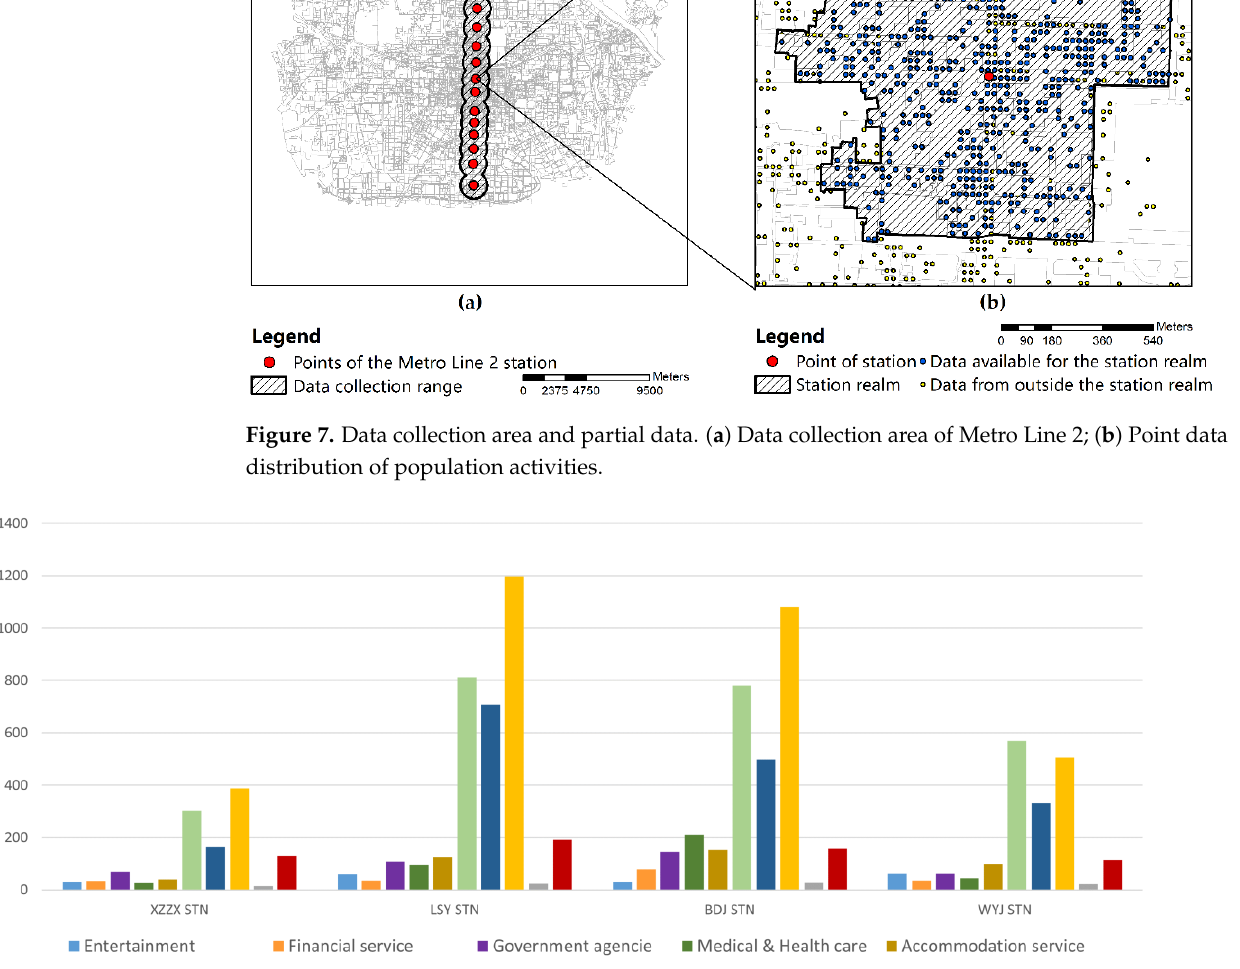
Figure 7. Data collection area and partial data. ( a ) Data collection area of Metro Line 2; ( b ) Point data distribution of population activities.